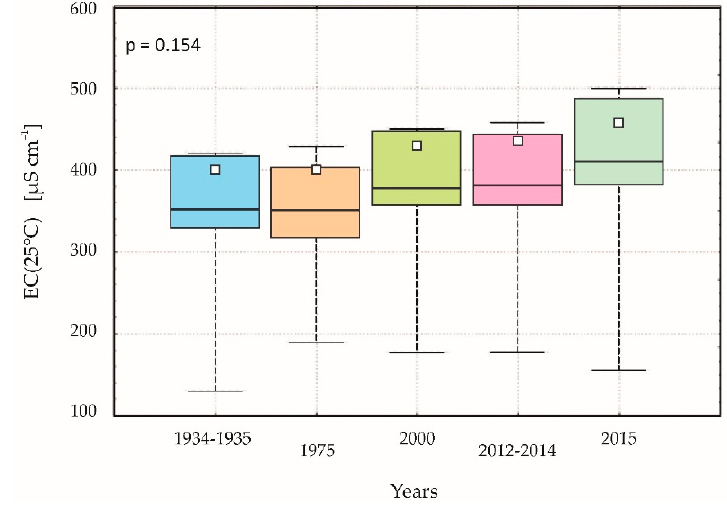
Figure 5. Boxplots (with p -value from the Kruskal–Wallis non-parametric test) for long term changes of surface water conductivity (EC25) in 11 SLP lakes. All boxplots show the median value with the box denoting interquartile range, the whiskers denote minimum and maximum, and the horizontal bars are mean values. Conductivity values for 1934–1935 and 1975 were estimated from the conductivity- bicarbonate statistical model based on data from [35,36] and [37], values for 2015 according to [43].